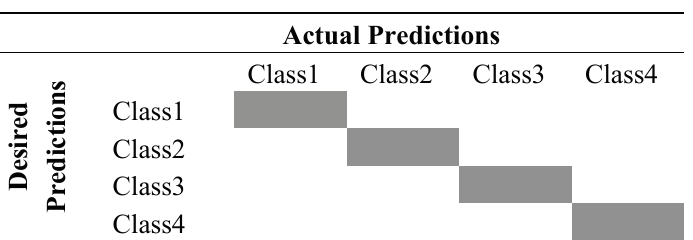
Table 7. Confusion